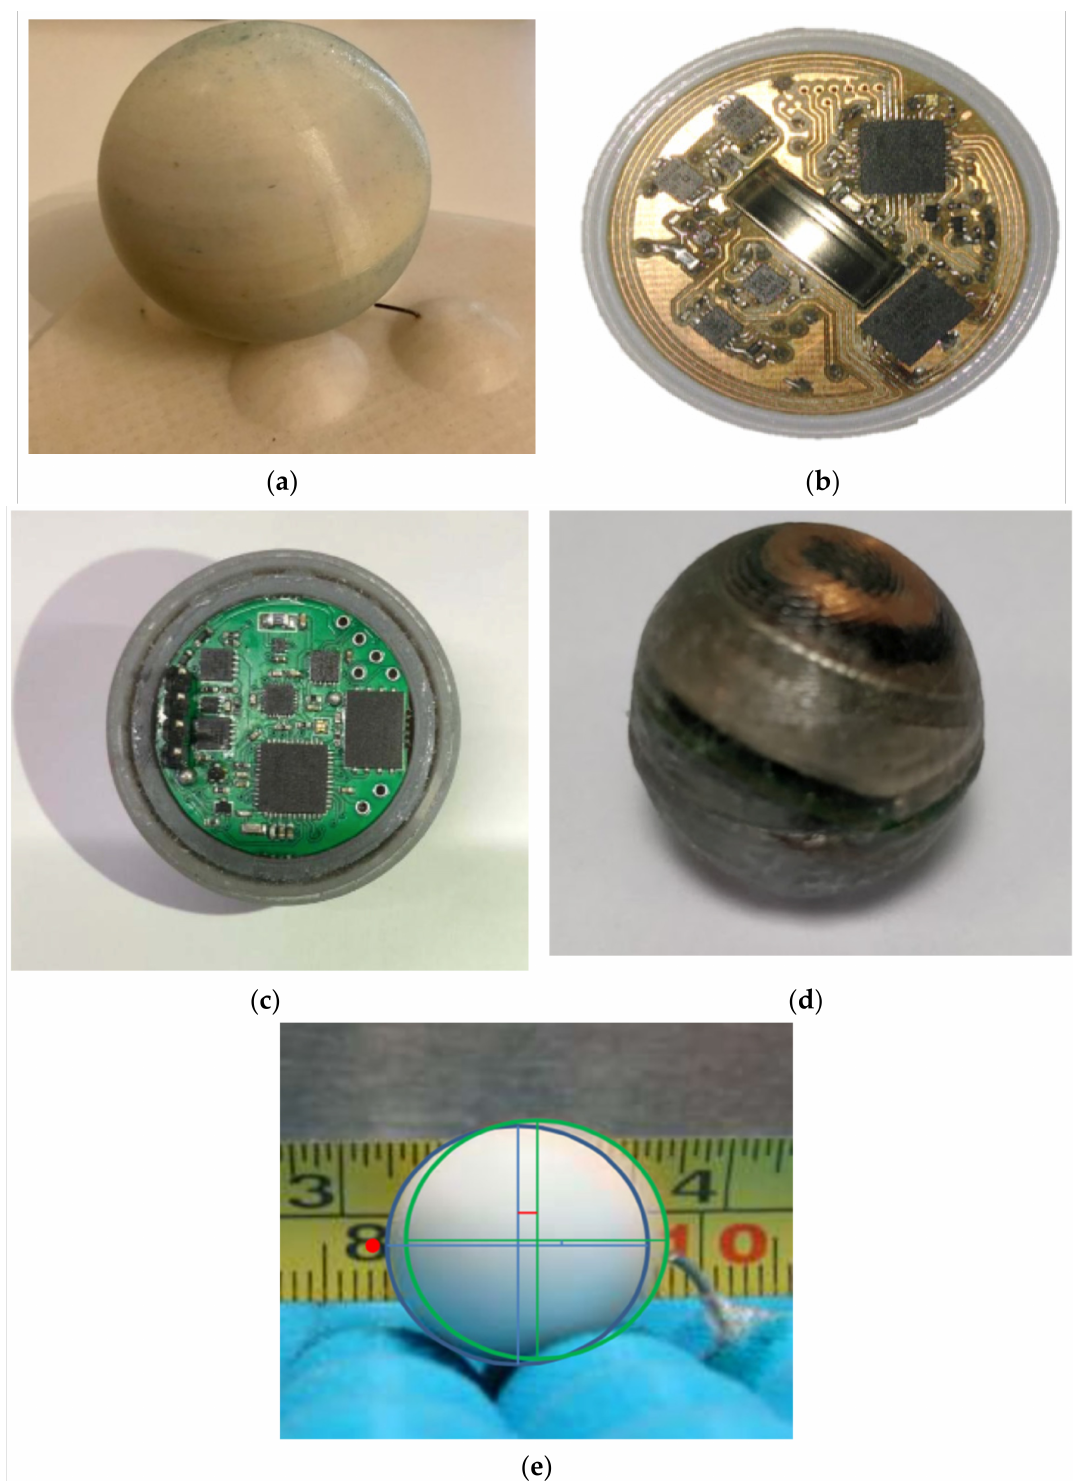
Figure 7. Photos of various developed instrumented particle designs with different external diameters of: ( a ) 70 mm, ( b ) 40 mm, ( c ) 30 mm, and ( d ) 20 mm; and ( e ) a spherical particle with 15 mm diameter, resting on a 3D printed bed of unisize bed material, also showing the pin restricting the full downstream entrainment of the spherical